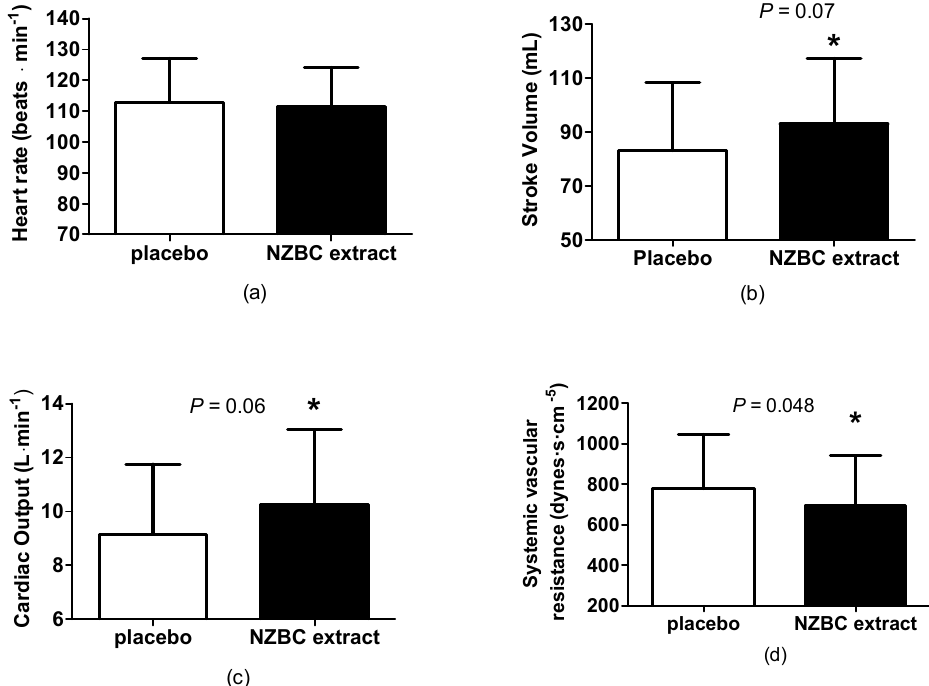
Figure 2. ( a ) Heart rate, ( b ) stroke, ( c ) cardiac output, and ( d ) systemic vascular resistance for the placebo and New Zealand blackcurrant extract during a 30-min treadmill walk at 5-MET. * indicates a difference or a trend for a difference between the placebo and NZBC extract conditions.